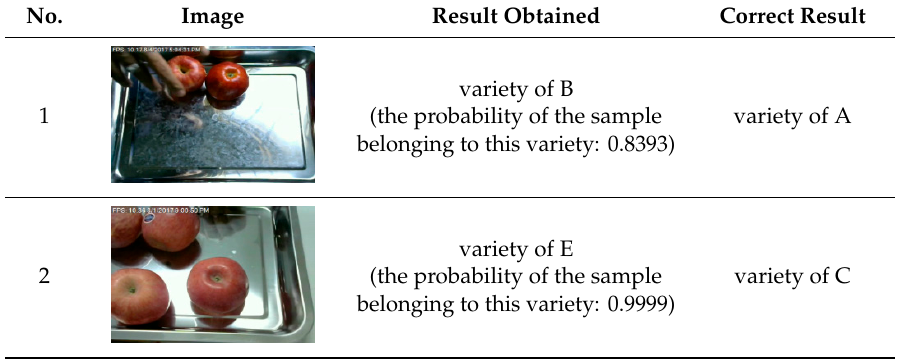
Table 5. Incorrect classification of original images for the CNN trained with original images. No. Image Result Obtained Correct Result